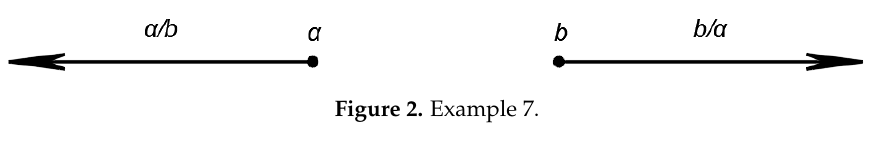
Figure 2. Example 7.